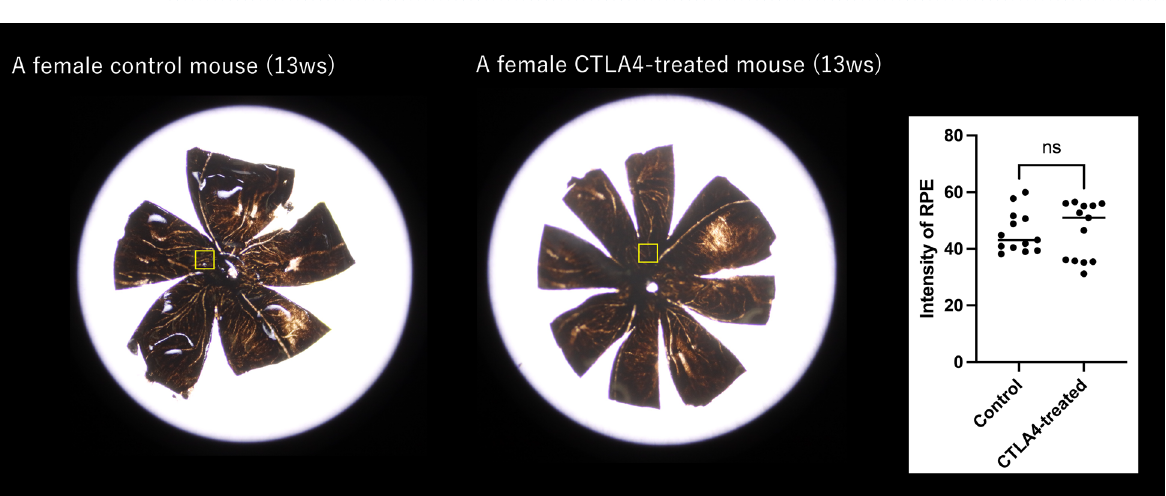
Figure 3. The mean intensity of choroidal flatmount at each lobule (100 × 100 pixels) in the control group and CTLA4 treated eyes was 45.88 ± 7.26 and 46.35 ± 9.99, respectively. There was no significant difference in the intensity of RPE. This result suggested that the depigmentation of the RPE was highly